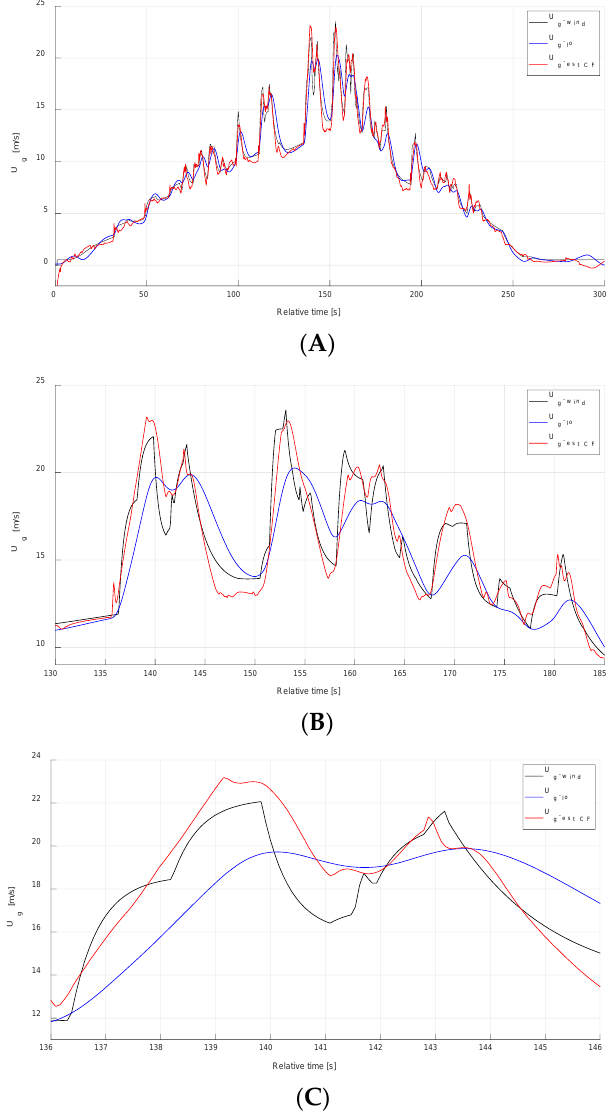
Figure 19. Comparison of the gust value with the estimation results (complementary filter, T c = 1.5 s, estimation delay reduced by 1 s)—flight crossing a gust area; ( A ) whole simulation, ( B ) several selected gusts, and ( C ) single selected gust.